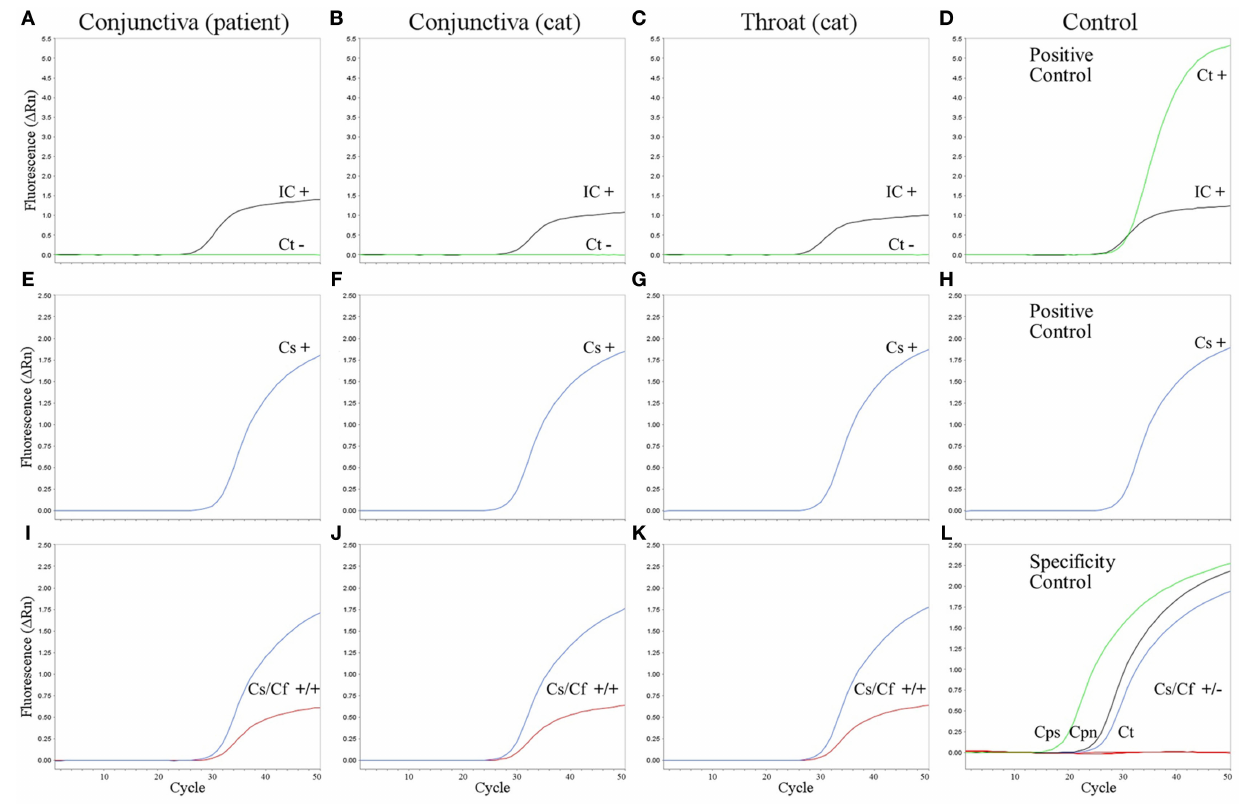
FIGURe 2 | Amplification plots of real-time PCR assays. C. trachomatis PCR (a–D) , pan- Chlamydia PCR (e–H) , and new pan- Chlamydia / C. felis duplex PCR assay (I–L) on the conjunctival swab from the patient (a,e,I) , conjunctival swab from the cat (B,F,J) , and throat swab from the cat (C,G,K) . (D,H) Positive controls. Results ( + , positive; − , negative) are given within the panels for internal control (IC, black), C. trachomatis (Ct, green), pan- Chlamydia PCR (Cs, blue), and the pan- Chlamydia / C. felis duplex PCR (Cs/Cf) containing both the genus-specific (Cs, blue) and the C. felis -specific probe (Cf, red). (L) Specificity controls of the new pan- Chlamydia / C. felis duplex PCR showing positive results with the genus-specific probe (green, black, and blue), but no cross-reactivity of the C. felis -specific probe (red). Three reactions are combined in one panel: DNA from C. psittaci (Cps, cell culture, 10 5 infection forming units per PCR), C. pneumoniae (Cpn, cell culture, 2 × 10 4 genomic copies per PCR), and C. trachomatis (Ct, from urethral swab specimen, 4 × 10 3 infection forming units per